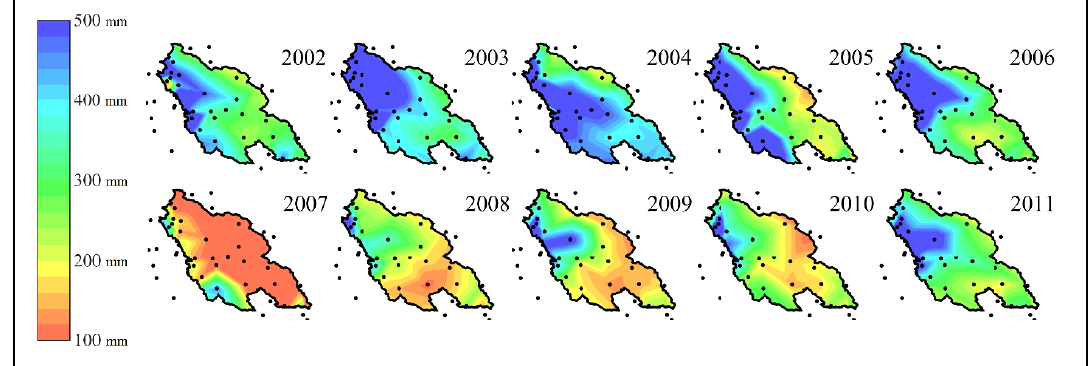
Figure 2. Distribution of the 22 precipitation stations inside and around the Bakhtegan catchment, and the interpolated annual precipitation rate (in mm) during the period January 2002 to December 2011. Y axis: the amount of annual precipitation (mm) in different catchment areas.